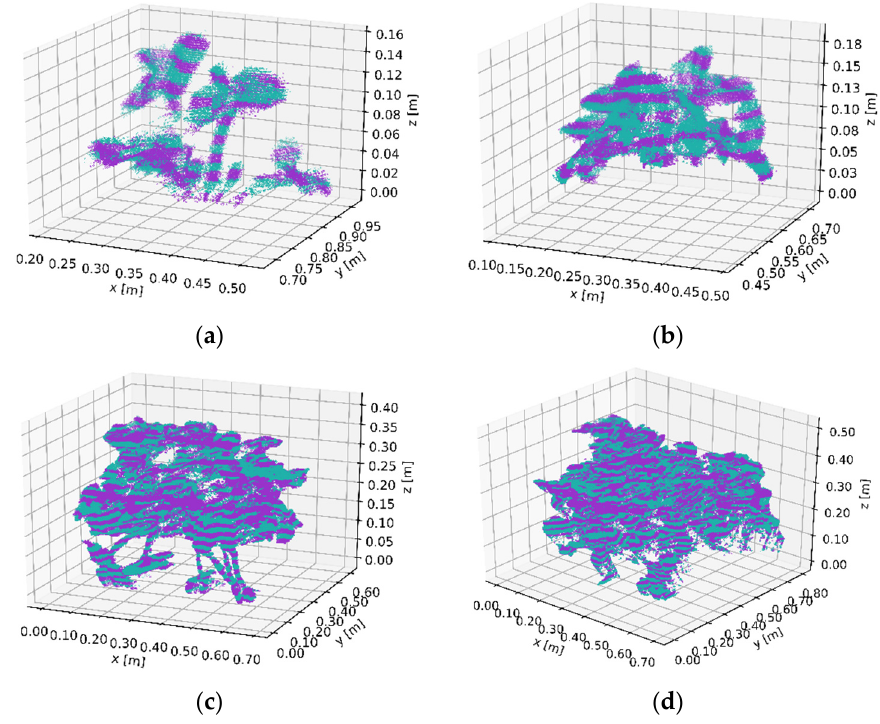
Figure 2. Point cloud of different size classes of strawberry plants: ( a ) juvenile-1, ( b ) juvenile-2, ( c ) mature-1, and ( d ) mature-2. In these figures, 1 cm slice height is shown for visualization.